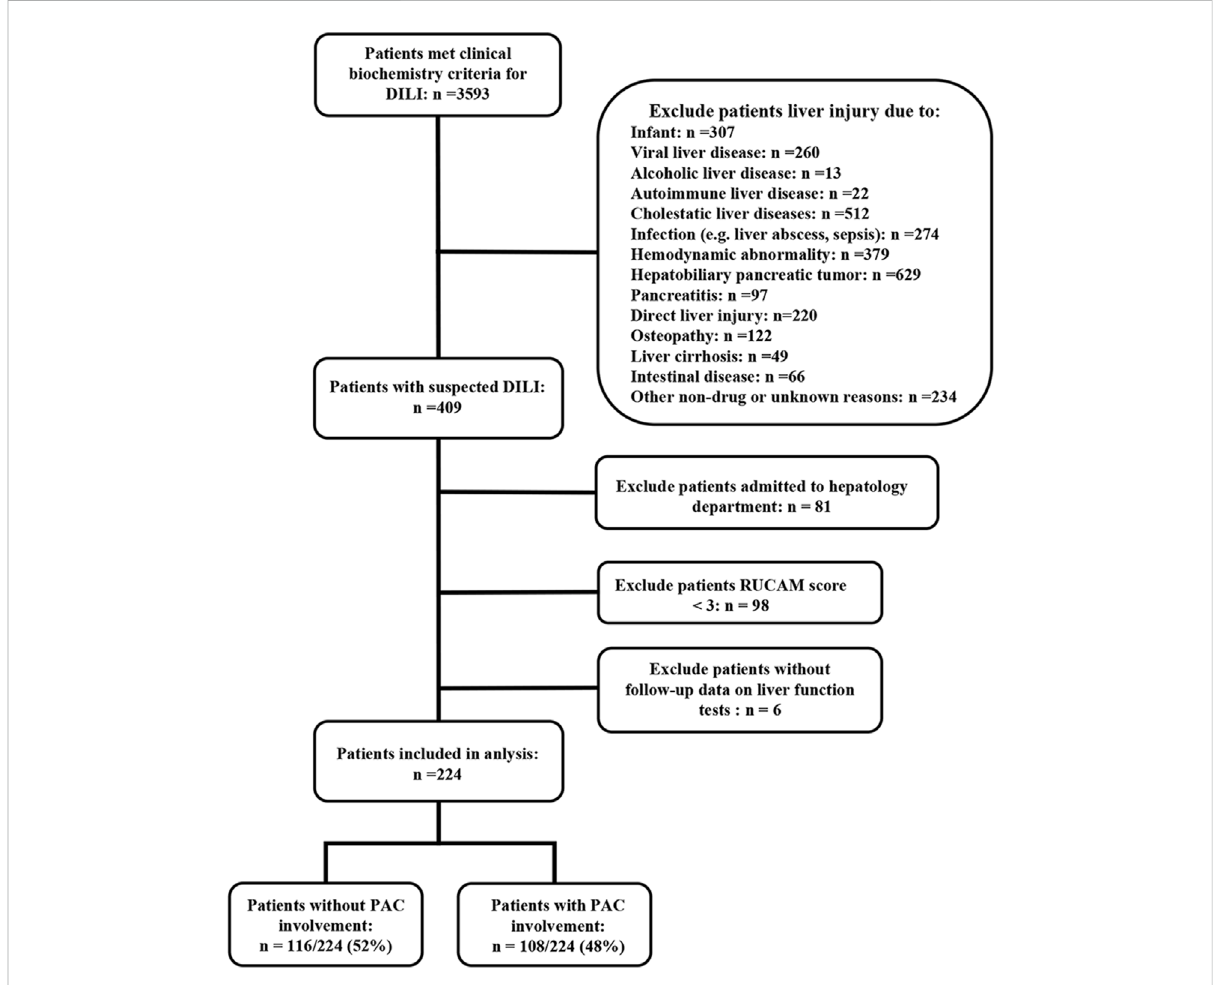
FIGURE 1 Flow diagram of patients included in the study. Abbreviations: DILI, drug-induced liver injury and PAC, pharmacist active